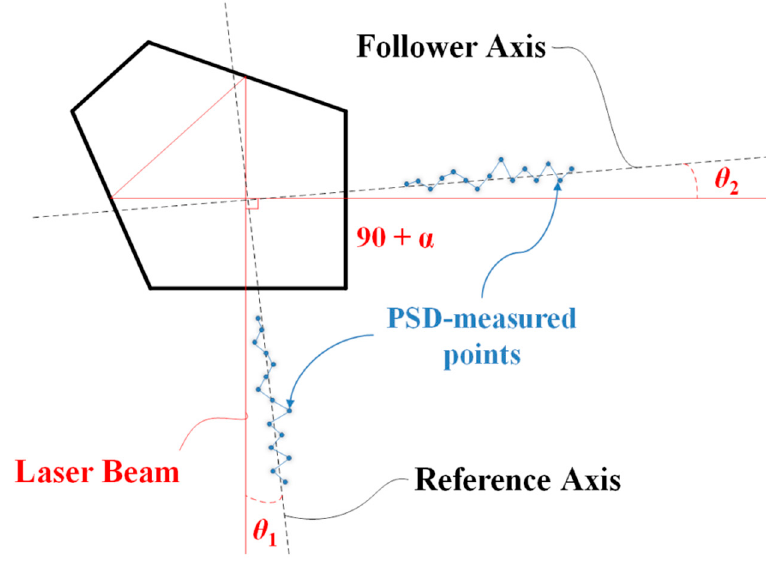
Figure 6. Beam path of perpendicularity measurement.